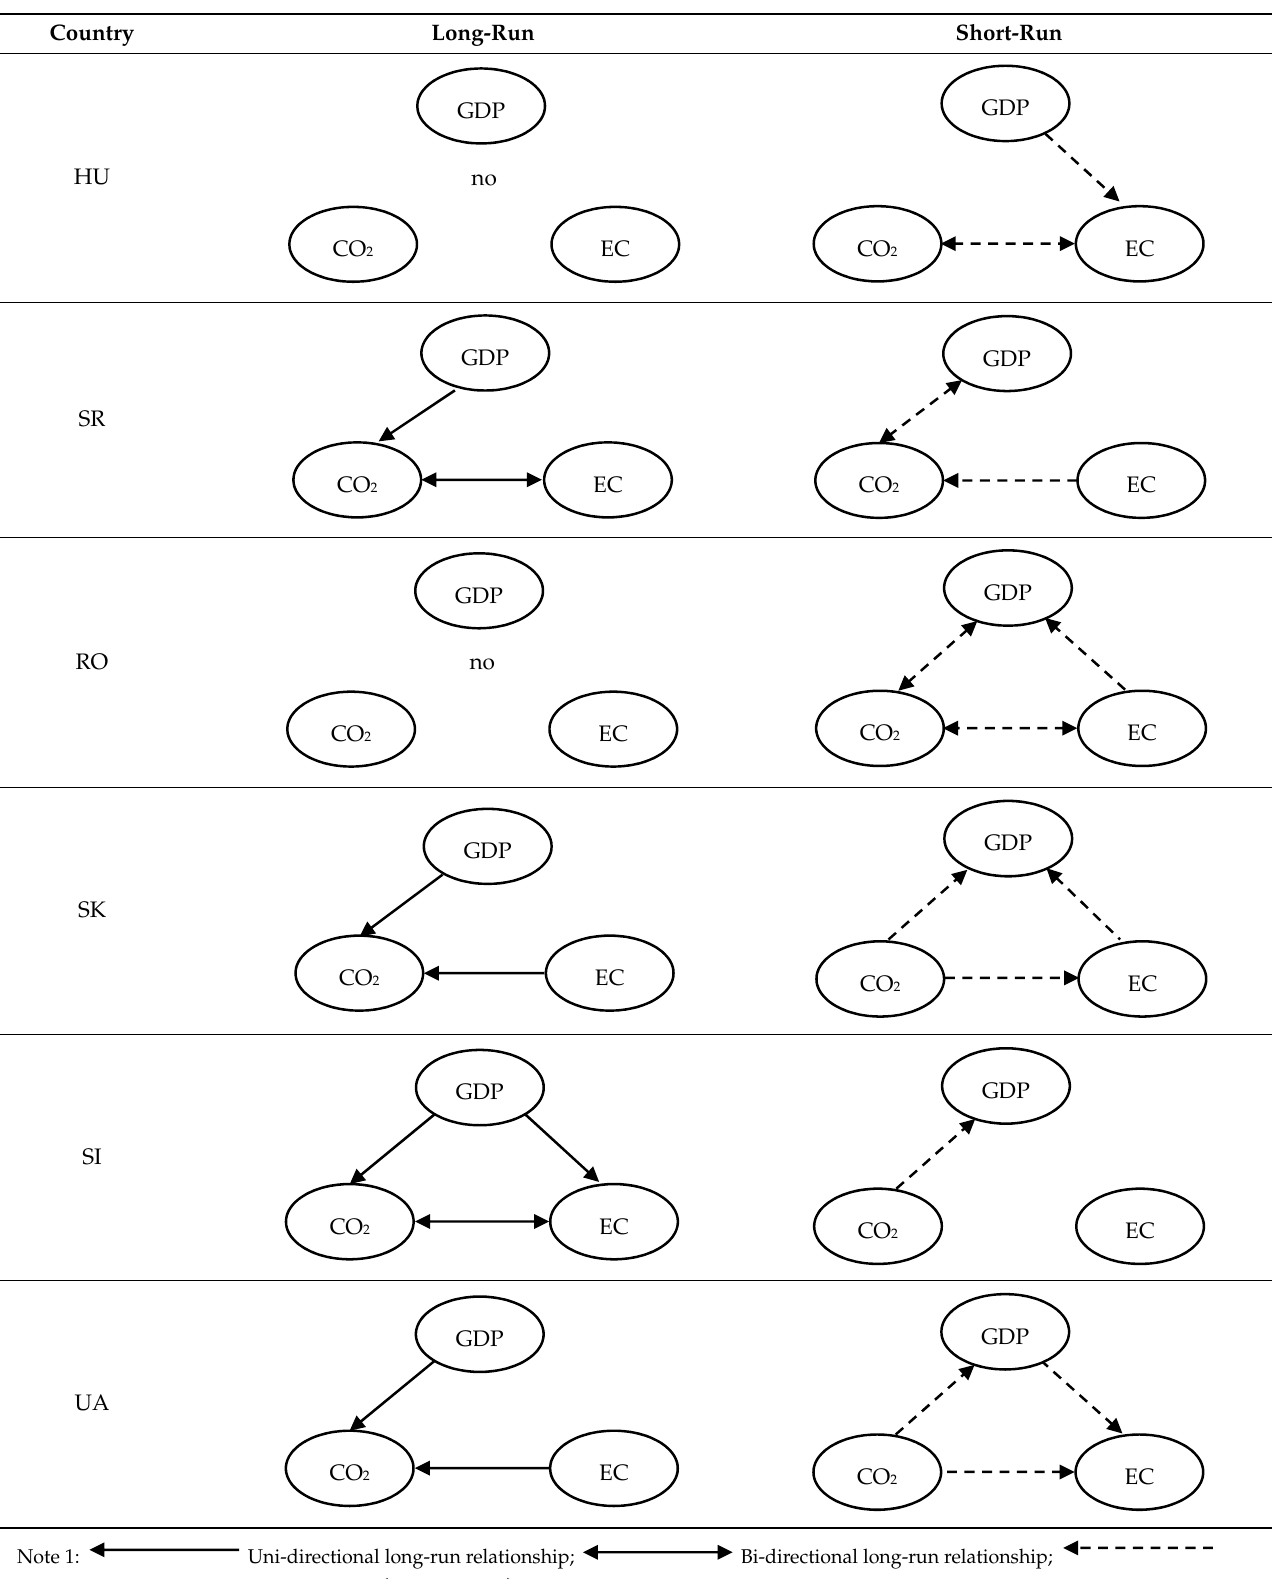
Bi-directional short-run relationship. Note 2: GDP—gross domestic product, CO 2 —carbon dioxide, EC—energy consumption.